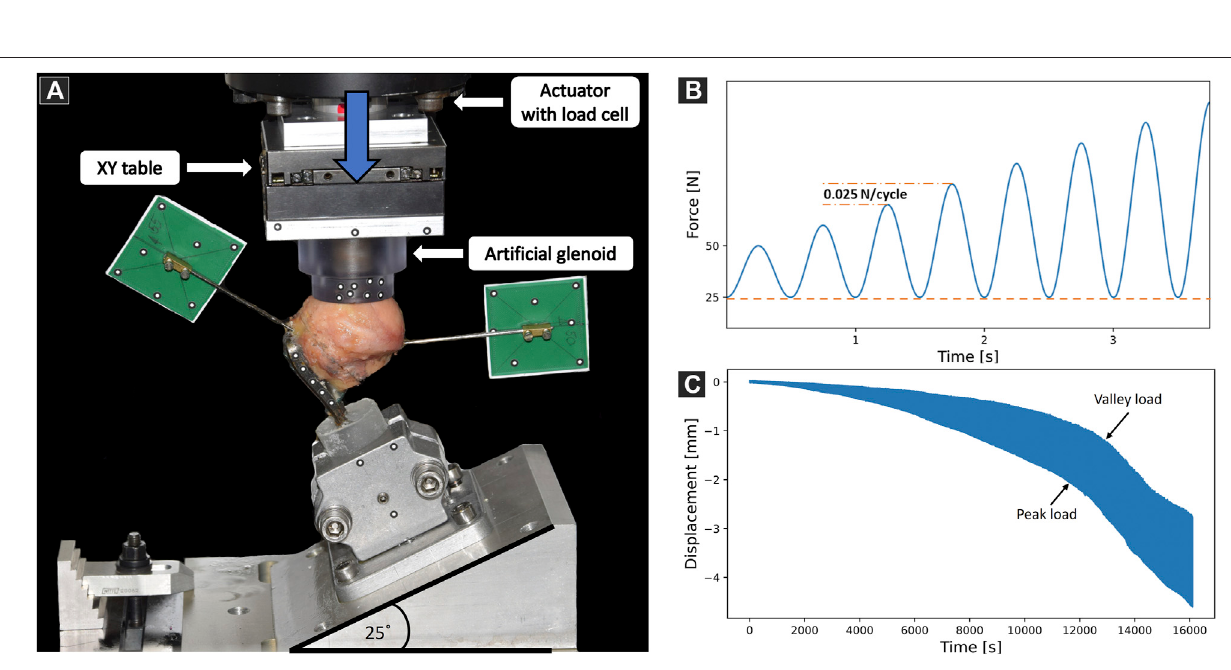
Frontiers in Bioengineering and Biotechnology |